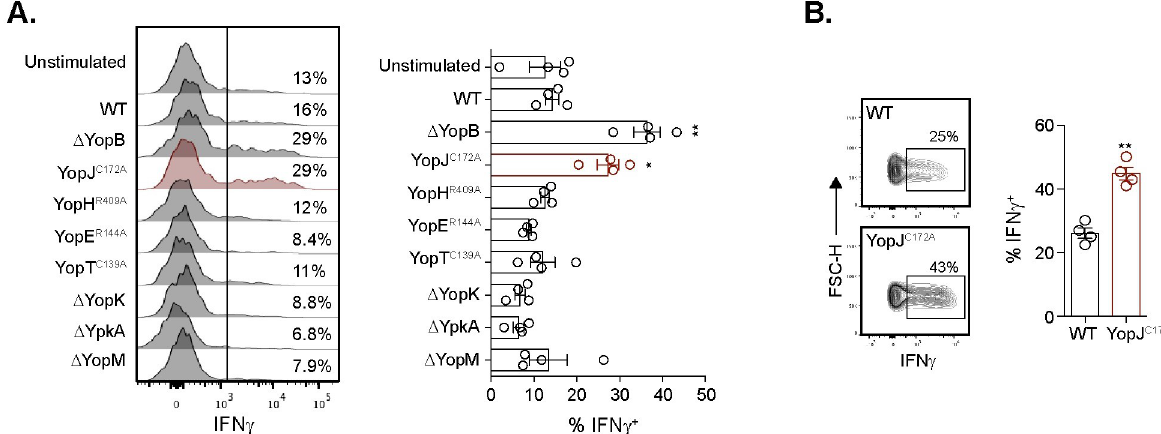
Fig 3. YopJ is necessary for inhibition of IFN γ production in murine V γ 4 and human V δ 2 + T cells. ( A ) MLN from L . monocytogenes infected mice were left unstimulated or stimulated with 10 MOI of the indicated Y . pseudotuberculosis for 24 hours. Antibiotics were given 2 hours post- stimulation and brefeldin A was added for the last 5–6 hours. V γ 1/2 - CD44 hi CD27 - γδ T cells were analyzed for IFN γ post stimulation. Representative histograms are displayed. The graph depicts mean ± SEM and represents at least two independent experiments with 2–4 mice per group. ( B ) Human PBMC were stimulated with 1 MOI of WT or YopJ C172A Y . pseudotuberculosis for 24 hours. Antibiotics were given 2 hours post- stimulation. Brefeldin A was added for the last 5–6 hours of stimulation. V δ 2 + γδ T cells were analyzed for IFN γ production post stimulation. Representative flow plots gated on V δ 2 + T cells are displayed. The graph depicts mean ± SEM and is pooled from 2 experiments with 4 healthy donors. �� p < 0.01 and � p < 0.05. A repeated measures one-way ANOVA was used for ( A ) and a paired t-test was used for ( B ). Experimental groups were compared to WT Y . pseudotuberculosis